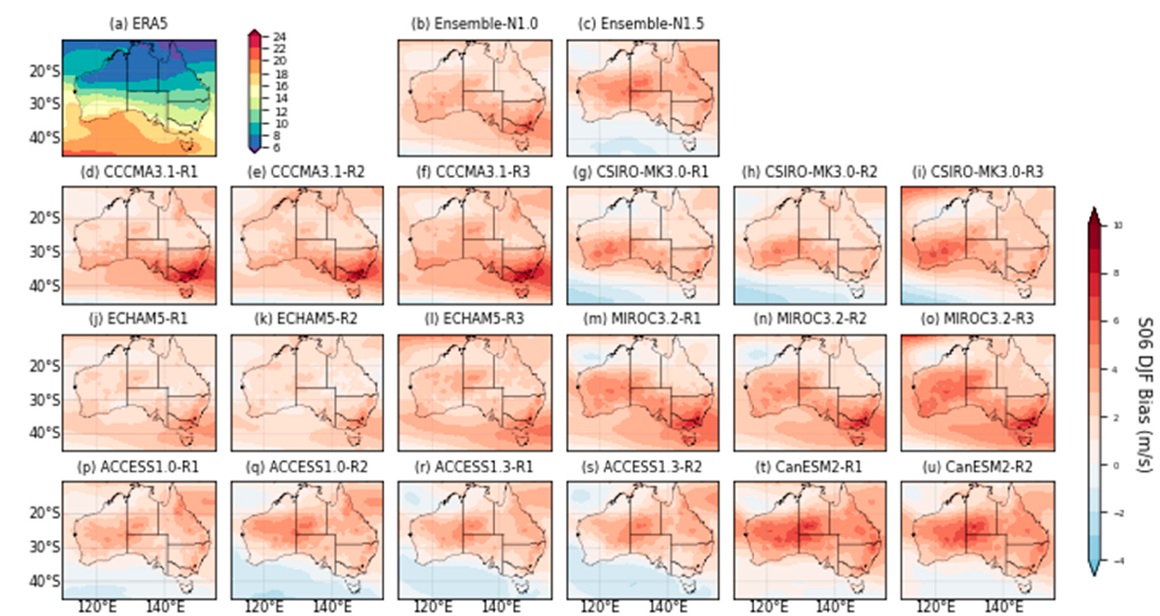
Figure A24. ( a ) Climatology mean summer (DJF) S06 from ERA5, ( b ) bias of the N1.0 and ( c ) N1.5 ensemble mean, ( d – o ) bias of the N1.0 and ( p – u ) N1.5 ensemble members in d01. Unit: m s − 1 .